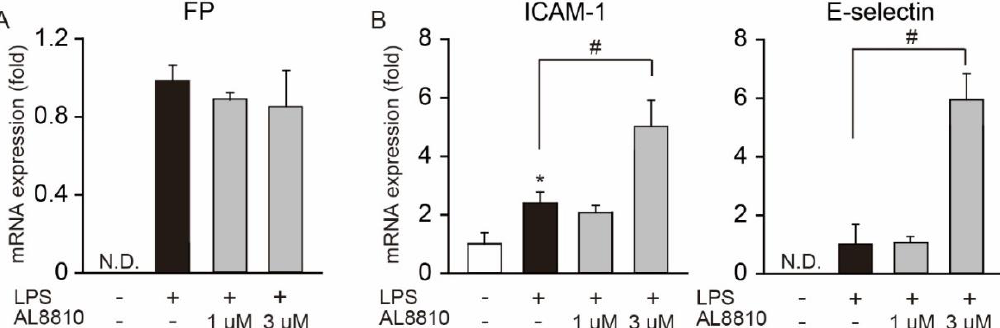
Figure 6. Inhibition of FP receptors on HUVECs enhanced the disruption of endothelium barriers. HUVECs were stimulated with 100 ng/mL LPS for 24 h. AL8810 was treated at 30 min before LPS stimulation ( n = 3). The expression levels of FP receptors ( A ), ICAM-1, and E-selectin ( B ) were measured by qPCR. * p < 0.05 vs. no-treated cells, # p < 0.05, as shown by brackets. N.D.: not detected.